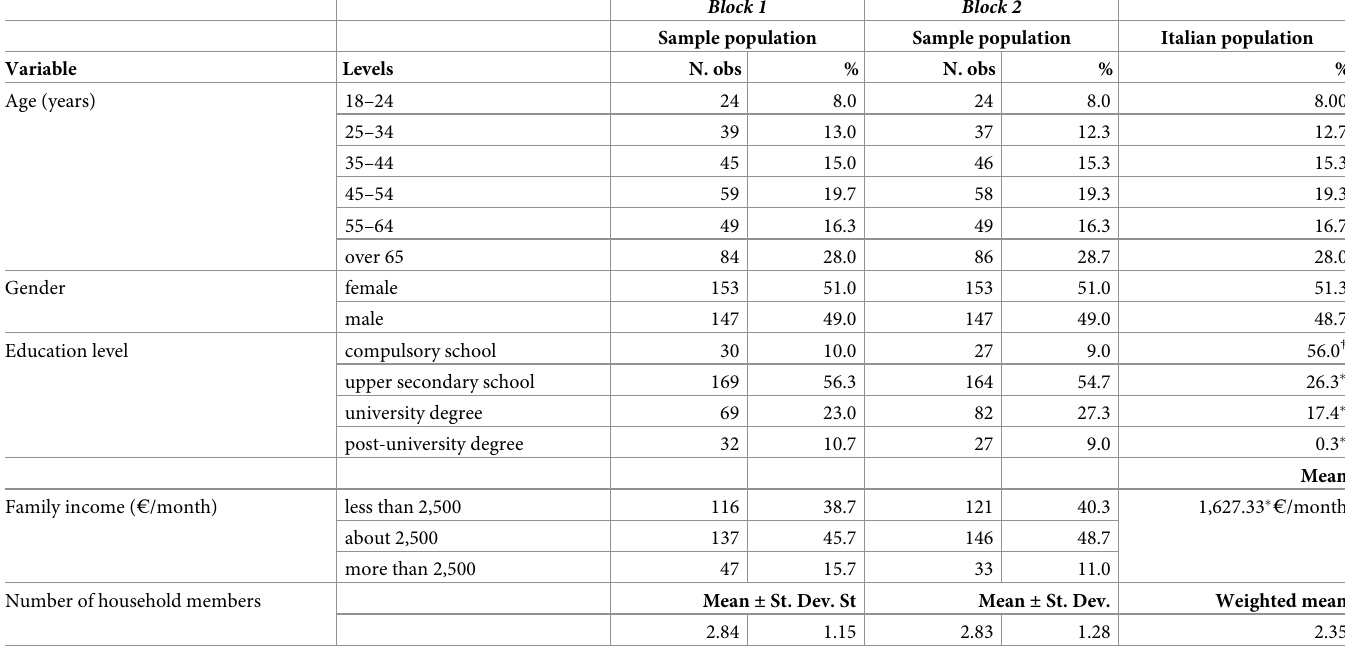
Table 1. Descriptive statistics.